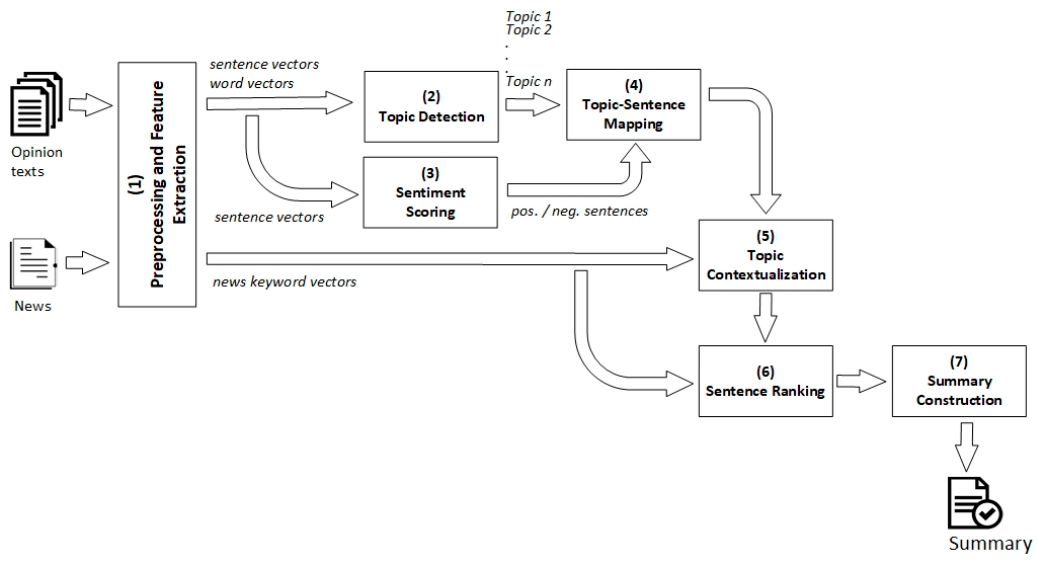
Figure 1. Workflow overview of the proposed model.